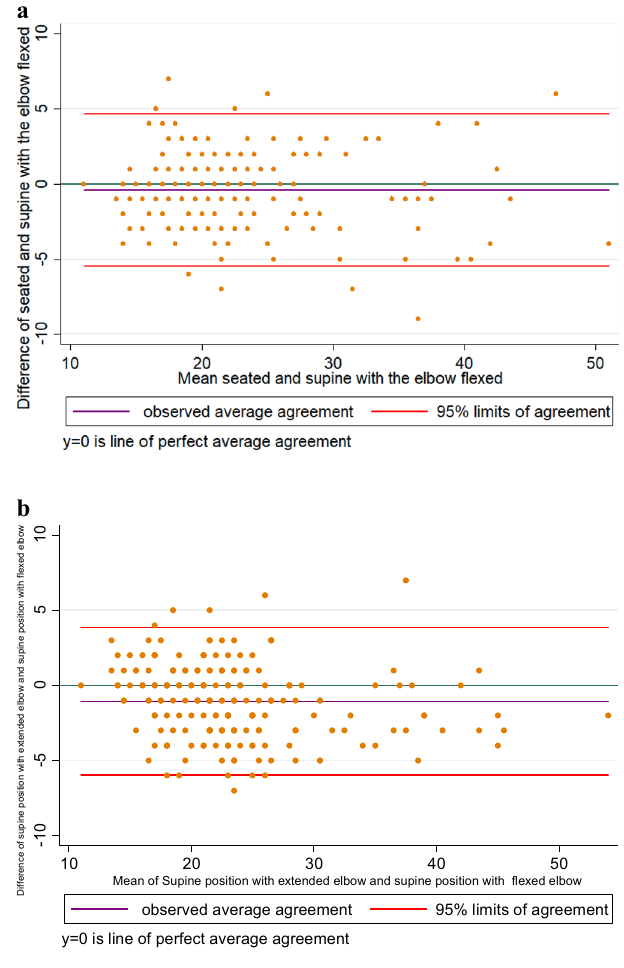
Figure 1. Level of agreement between ( a ) sitting versus supine position with a flexed elbow, ( b ) supine position with an extended elbow and supine position with a flexed